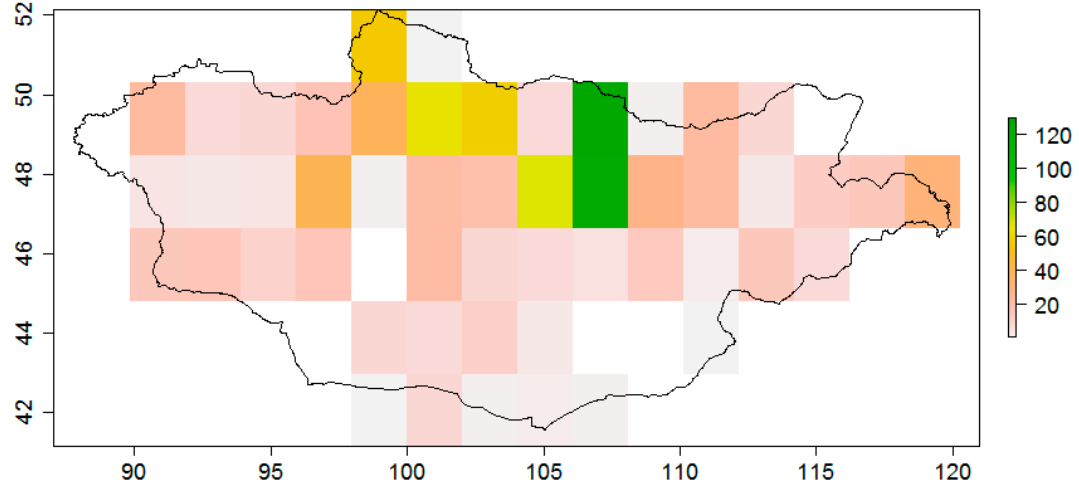
Figure 2. A map of study region (Mongolia) with distribution of 2 ◦ × 2 ◦ grid cell records. Colors represent the species richness ( n = 301) within grid cells.